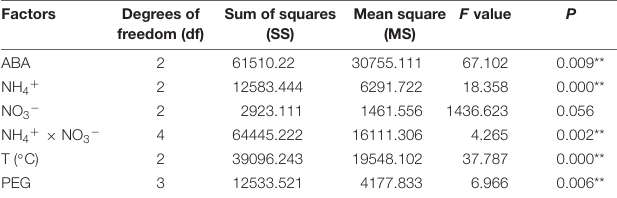
TABLE 2 | Variance analysis of the effects of different ABA and PEG concentrations, N source, and temperature on synchronous somatic embryogenesis of Pinus elliottii × Pinus caribaea. Factors